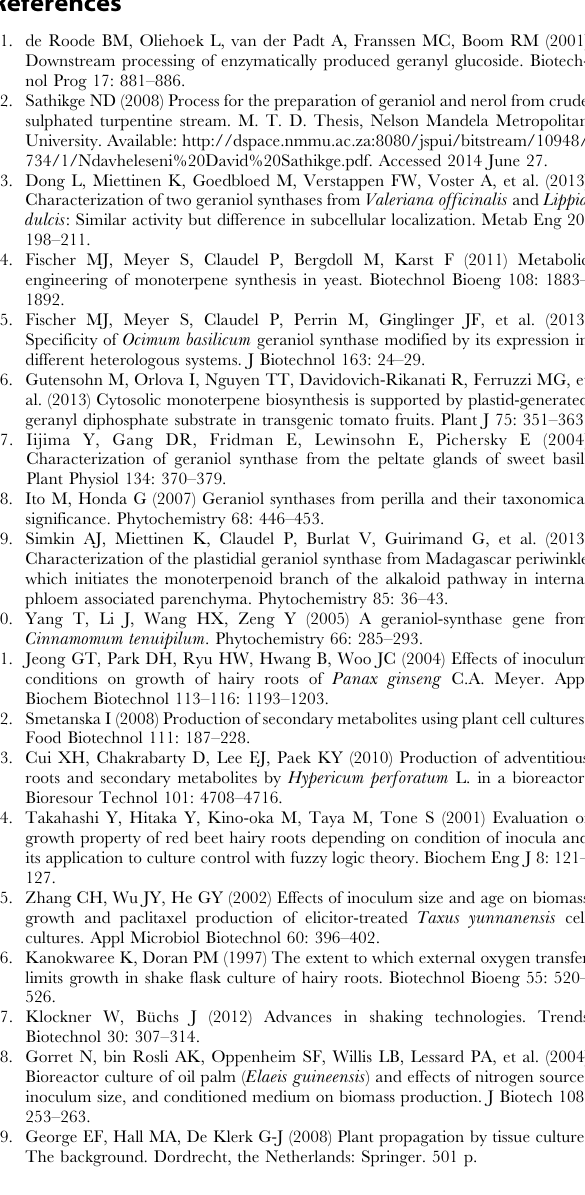
Table S3 Analysis of Variance table for the model with all main effects and 2-factor